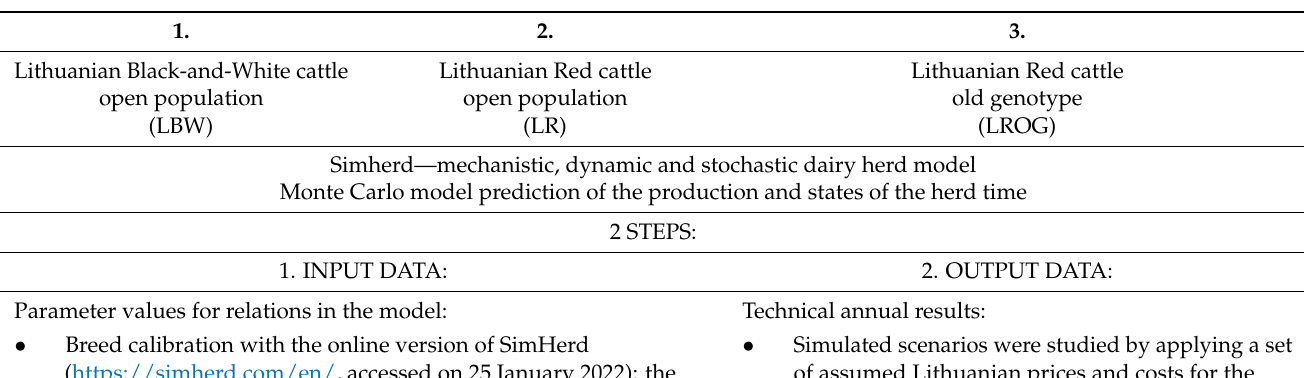
Table 1. Schematic diagram showing stages of the SimHerd model.